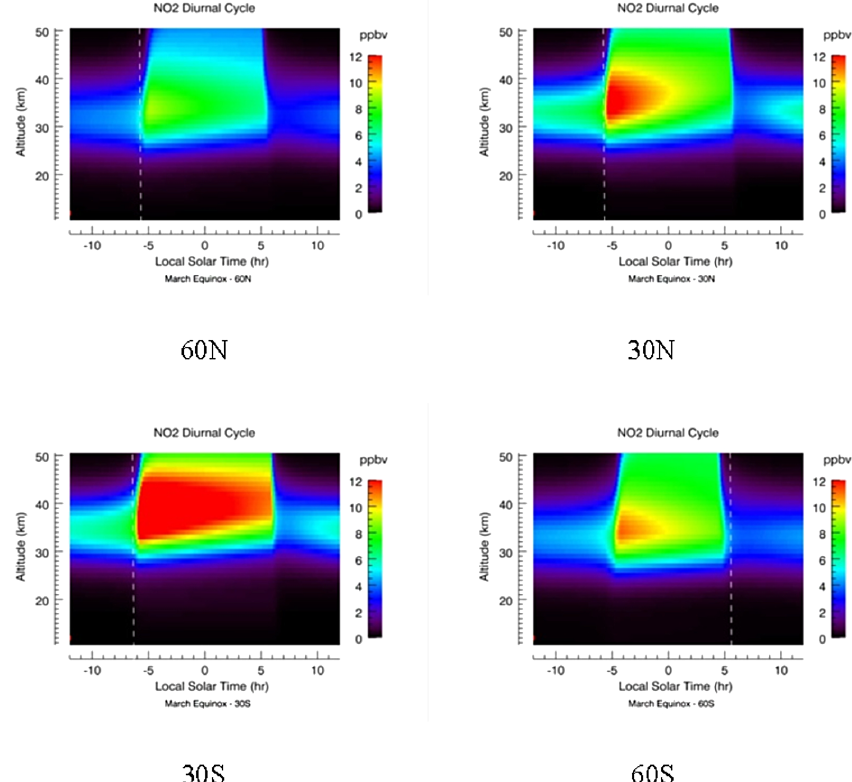
Figure 2. Diurnal variation of NO 2 (21 March 2005) from the photochemical model described in McLinden et al.